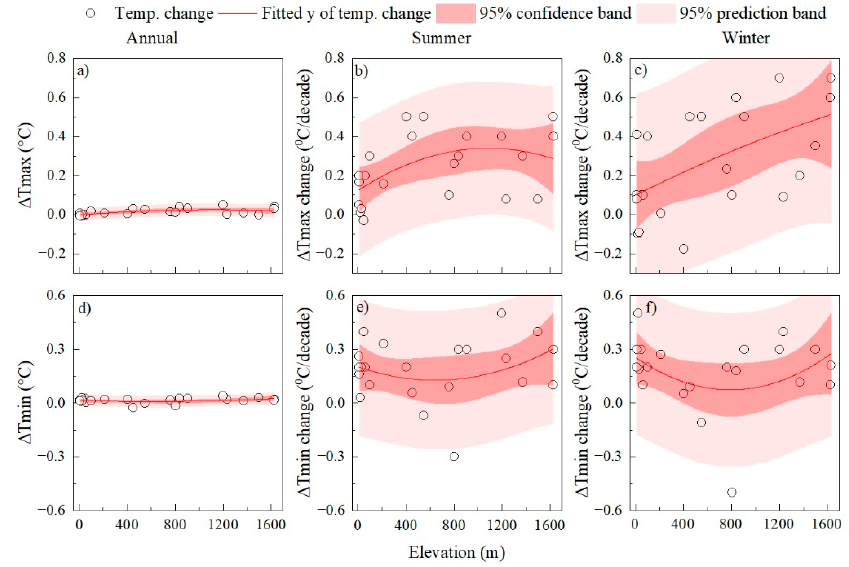
Figure 3. Trend magnitudes of ( a ) annual Tmax, ( b ) summer Tmax, ( c ) winter Tmax, ( d ) Annual Tmin ( e ) summer Tmin, and ( f ) winter Tmin according to the elevation. Open circles, dark panels, light panel and solid line indicate calculated values, 95% confidence band, 95% prediction band and best curve-fit line,